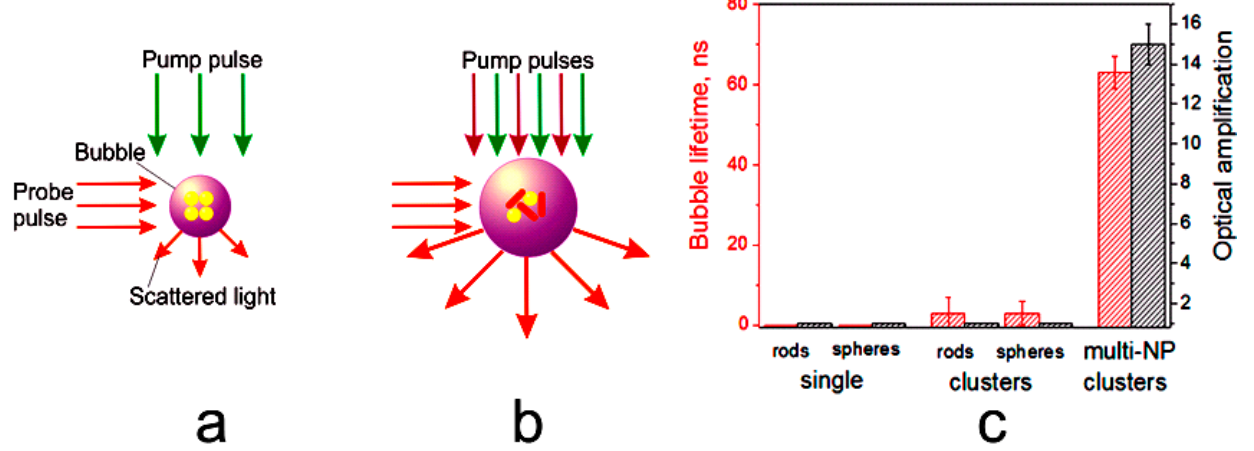
Figure 3. The mechanism of a rainbow PNB: ( a ) generation of the PNB with a single type of plasmonic NP and the matching excitation wavelength of a single laser pulse; ( b ) generation of the PNB with two types of plasmonic NPs (mixed in one cluster) and two simultaneous laser pulses having two different wavelengths that match each type of NP; ( c ) PNB parameters (lifetime and the relative amplification of optical scattering by a PNB compared to that of NPs) obtained under simultaneous excitation with two laser pulses at 532 nm and 787 nm for individual NPs and their clusters consisting of a single NP type (case (a)) and for the mixed cluster (case (b))